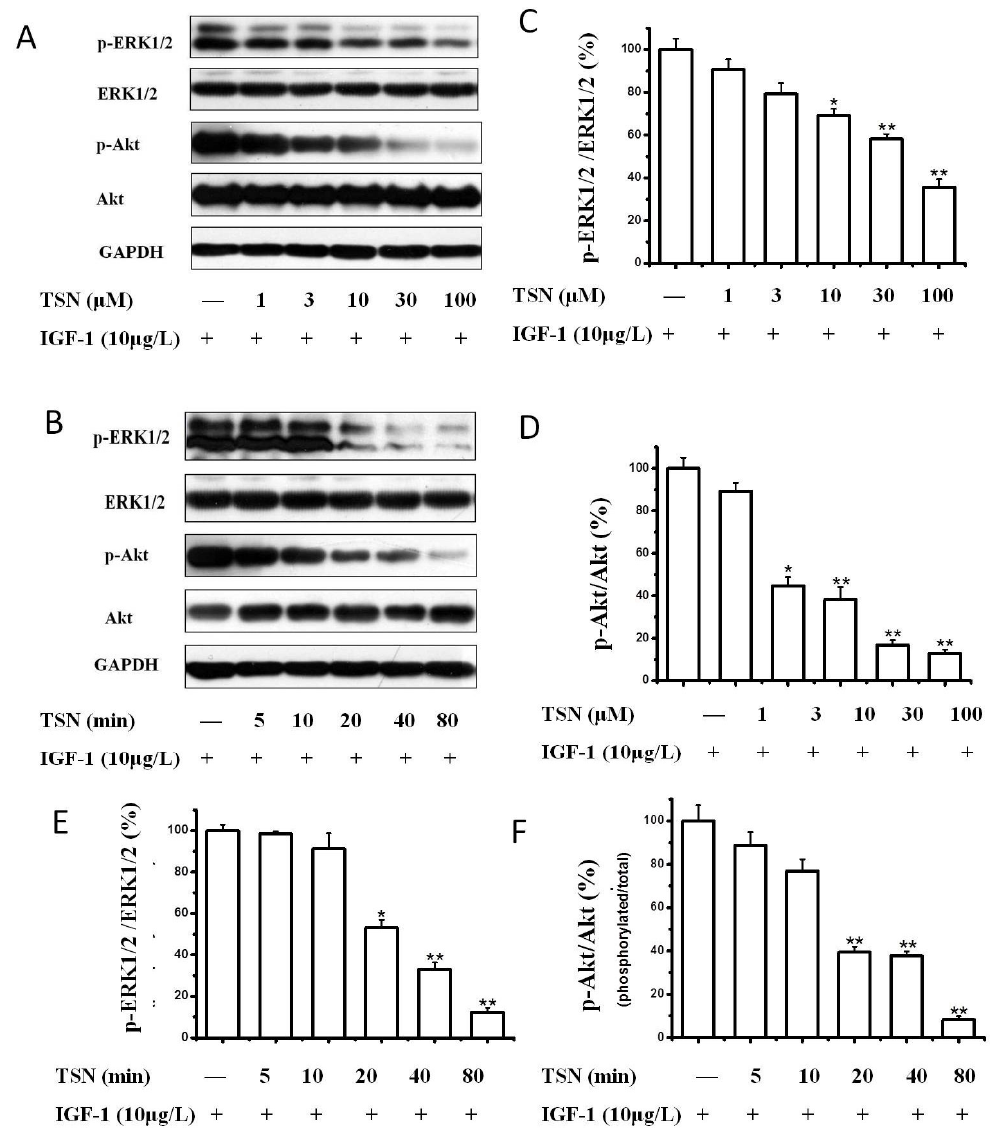
Figure 5. TSN attenuated the activation of Akt and ERK1/2 in PC12 cells in a dose- and time-dependent manner. ( A ) Cells were pre-treated with various concentrations of TSN, and then incubated with 10 µ g/L IGF-1 for 10 min. The expressions of p-Akt and p-ERK1/2 were determined by Western blotting; ( B ) Cells were pretreated with 20 µ M TSN at various time points and then incubated with IGF-1 for 10 min. The expressions of p-Akt and p-ERK1/2 were determined by Western blotting; ( C – F ) Relative levels of p-Akt versus total Akt and p-ERK1/2 versus ERK1/2 in each sample were determined by the densitometry of the blots. Densitometric analysis of the blots was expressed as a percentage of control. The results are shown as the mean ± SEM and represent three independent experiments, * p < 0.05, ** p < 0.01 versus control.